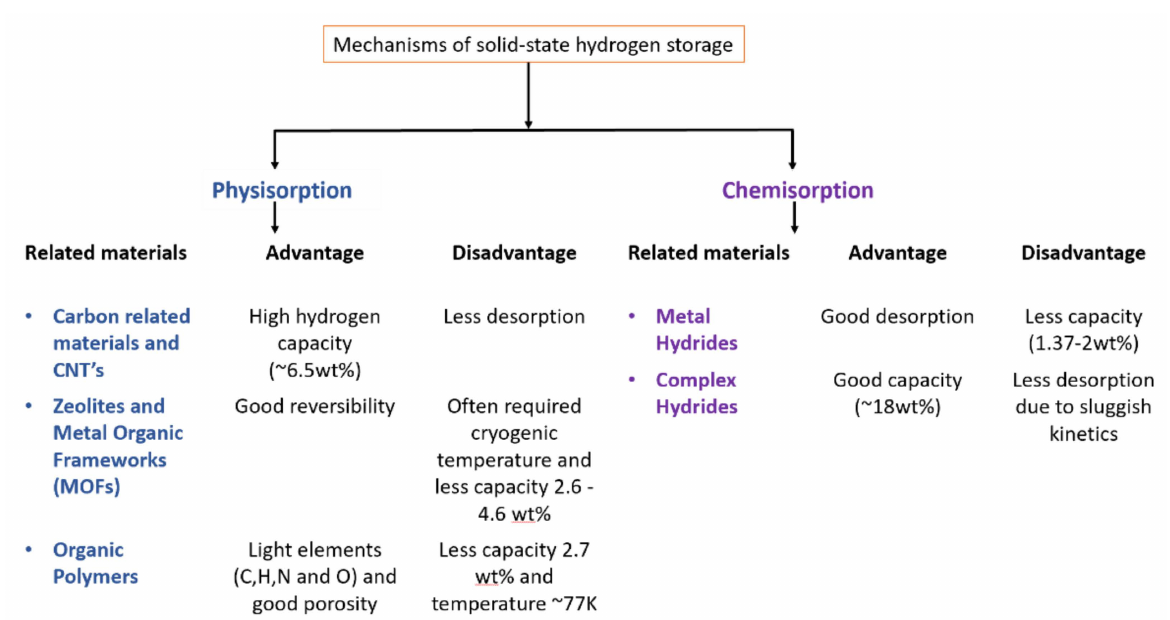
Figure 2. Solid-state hydrogen storage mechanisms, related materials and their advantages and